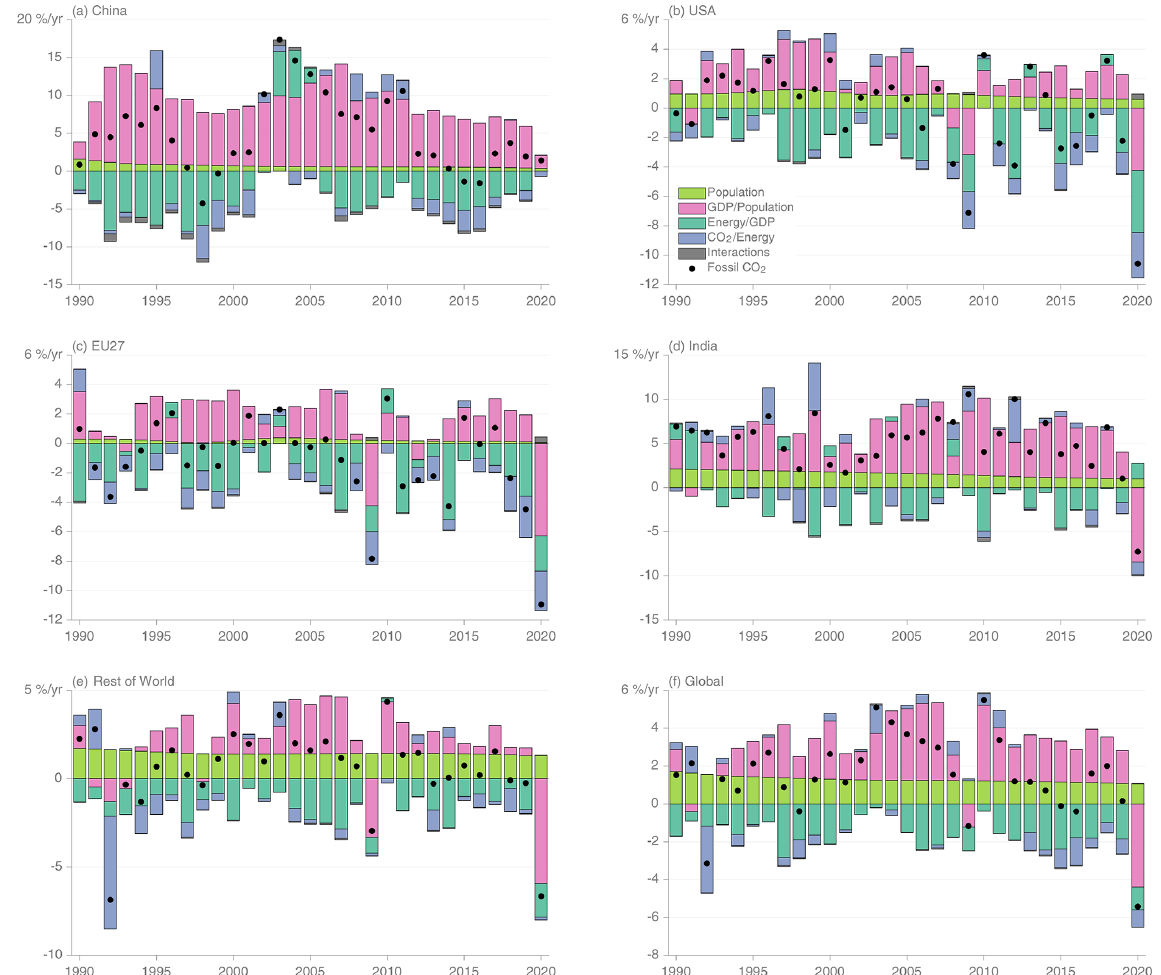
Figure 14. Kaya decomposition of the main drivers of fossil CO 2 emissions, considering population, GDP per person, energy per GDP, and CO 2 emissions per energy use, for China (a) , USA (b) , EU27 (c) , India (d) , the rest of the world (e) , and the world (f) . Black dots are the annual fossil CO 2 emissions growth rate, coloured bars are the contributions from the different drivers. A general trend is that population and GDP growth put upward pressure on emissions, while energy per GDP and more recently CO 2 emissions per energy put downward pressure on emissions. The changes during 2020 led to a stark contrast to previous years, with different drivers in each